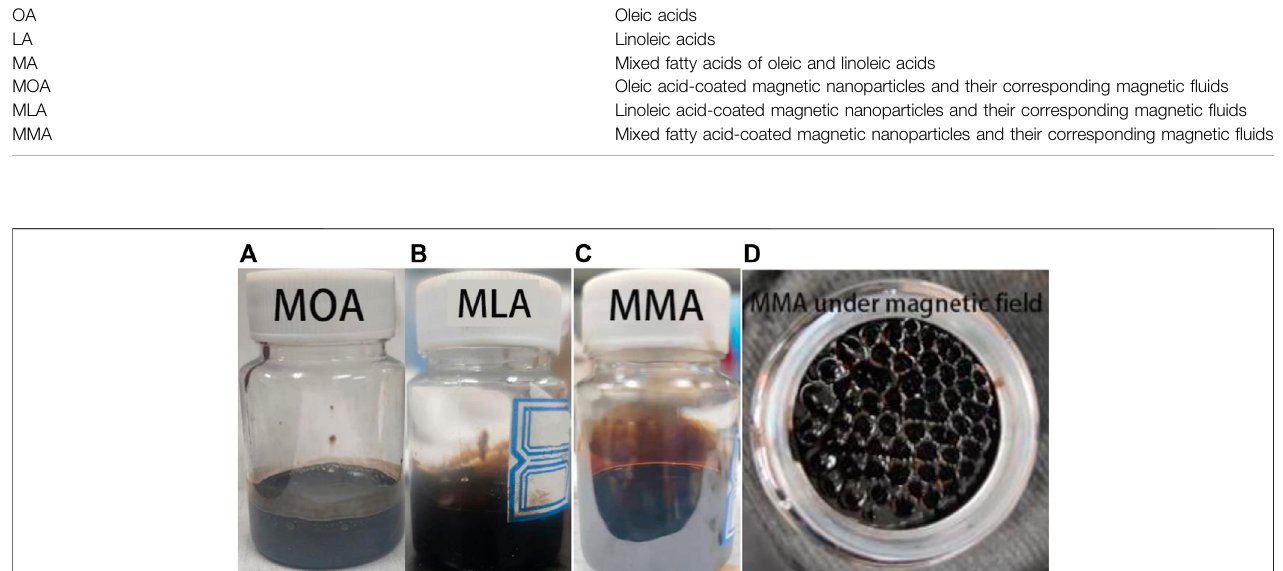
TABLE 1 | Labels for different samples and their meanings. Labeling of different samples OA